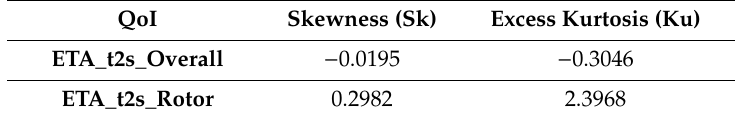
Table 3. SB-UQ: 3rd and 4th order moment statistics values for rotor and ‘overall’ e ffi ciency. QoI Skewness (Sk) Excess Kurtosis (Ku) ETA_t2s_Overall − 0.0195 − 0.3046 ETA_t2s_Rotor